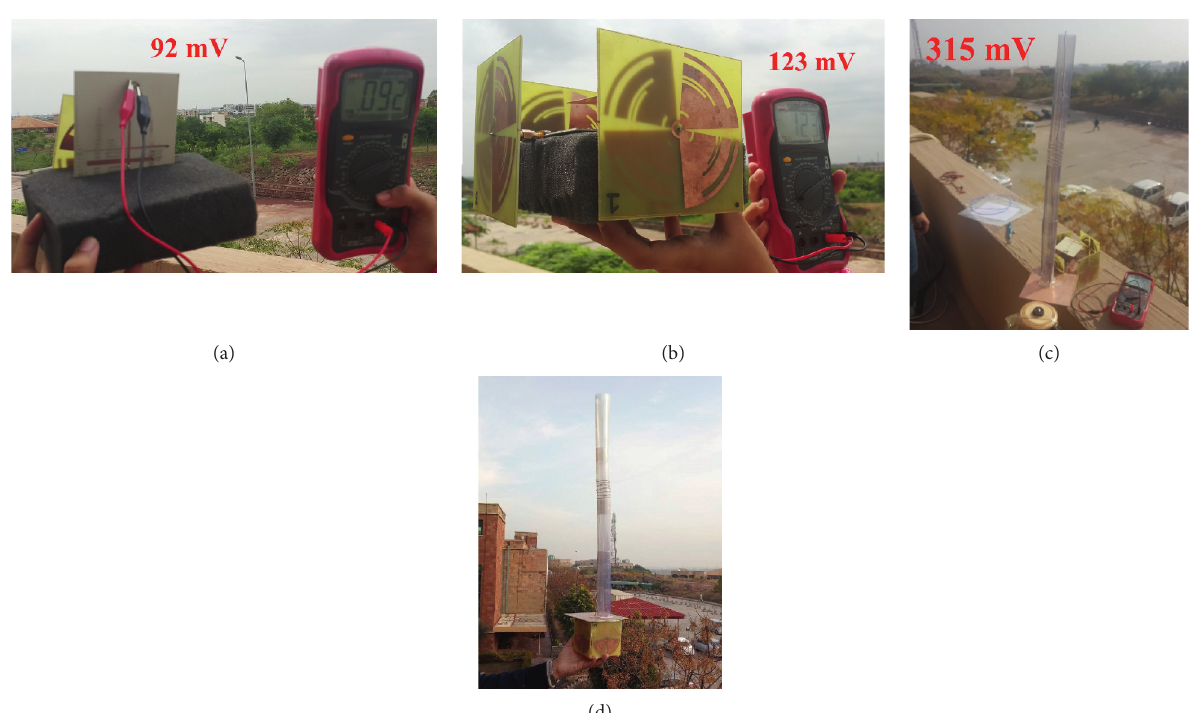
Figure 33: Ambient environment testing setup for the rectenna using (a) single multiband antenna element, (b) proposed cube rectenna without FM antenna, (c) proposed cube rectenna (open), and (d) proposed cube rectenna